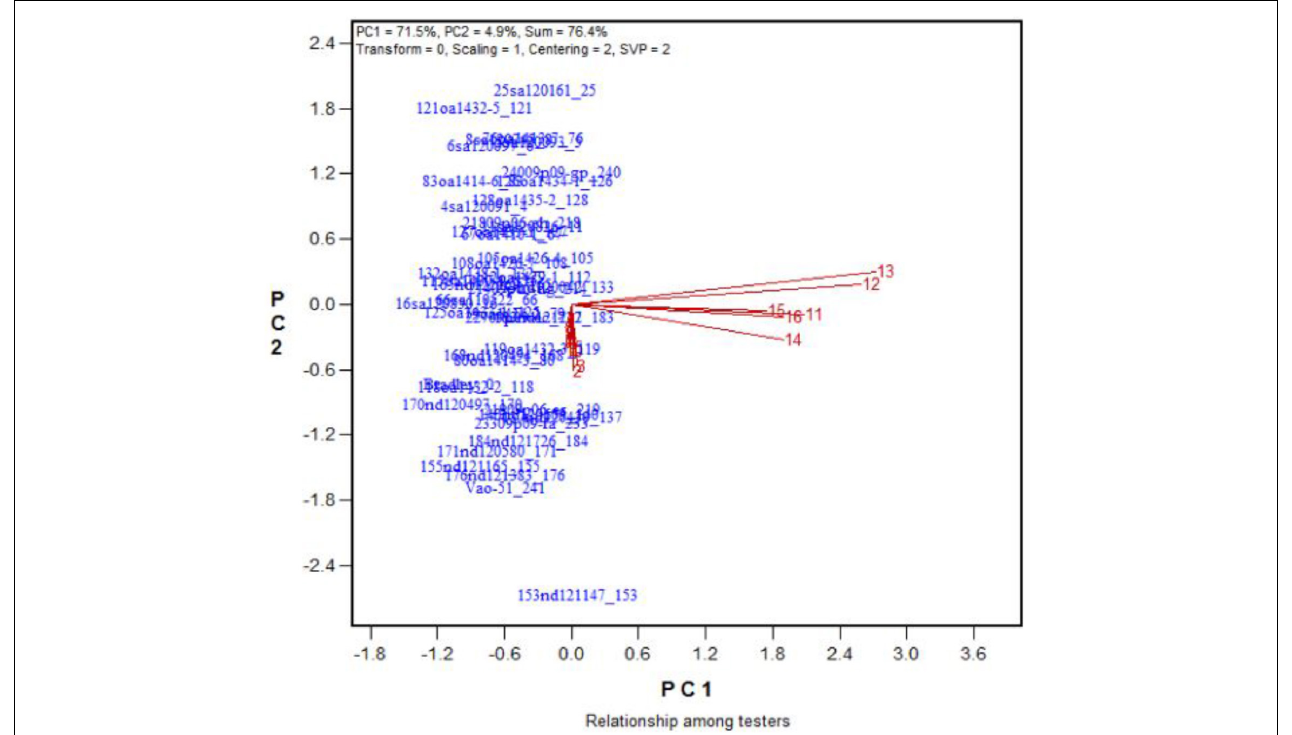
FIGURE 10 | Effects of 16 treatments on the DNY leaves for 43 oat genotypes. See descriptions for each treatment in Table 1 . DNY leaves = dry and not yellow.